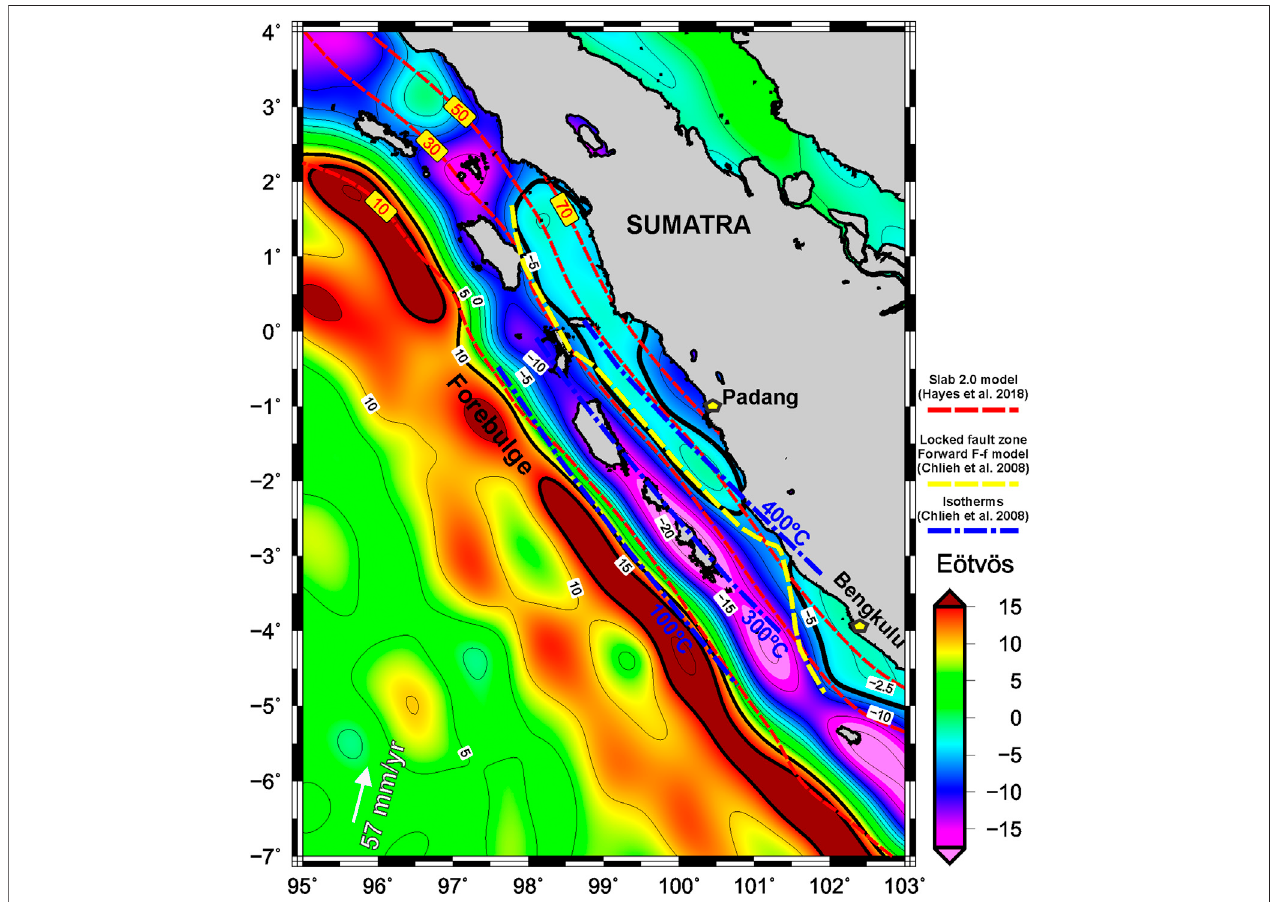
FIGURE 11 | Topography corrected vertical gravity gradient (Tzz) obtained from GOCE model GO_CONS_GCF_2_DIR_R6 up to N (cid:1) 200 (Bruinsma et al., 2014). Superimposed: isotherms (blue dot and dashed line) and down-dip limit (yellow dashed line) of the locked fault zone from the forward model F-f of Chlieh et al. (2008). Slab depthsfrom Slab2.0 of Hayes (2018) are plotted with red dashed lines. Note the correspondence between the − 5 Eötvös contour and the approximate location of the 350 ° C isotherm that marks the limit of the seismogenic zone in this region and with the down-dip limit of the locked zone. The up-dip limit of the seismogenic zone can be identi fi ed by the high gradient indicated by the +15 Eötvös contour.